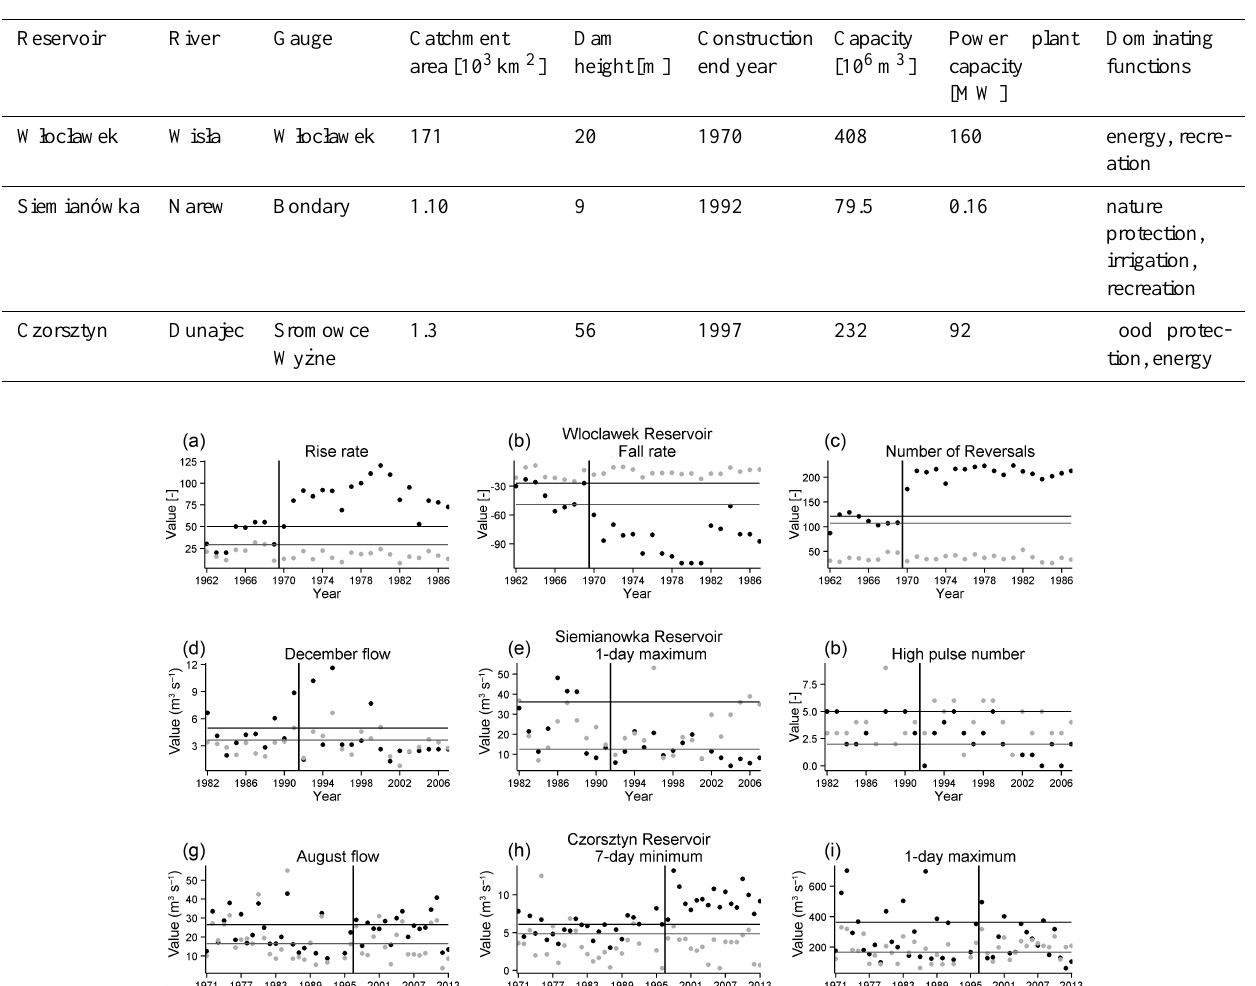
Table 1. Main features of investigated reservoirs.